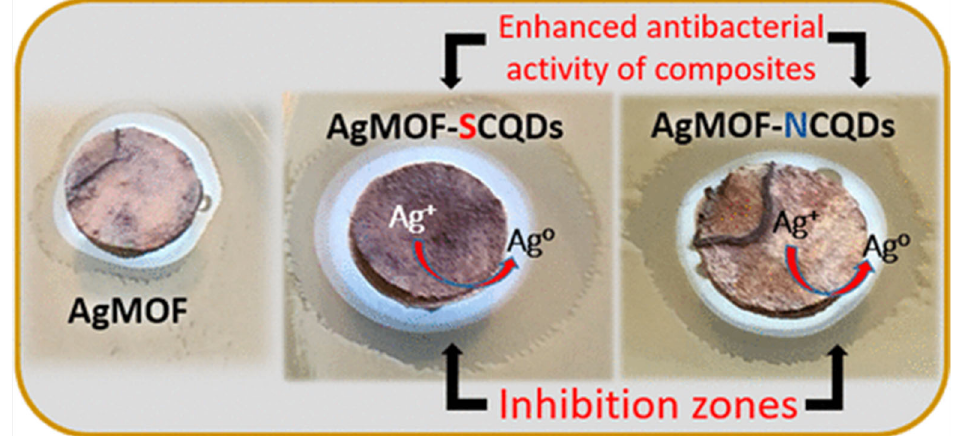
Figure 26. Antimicrobial activity of AgMOFs ‐ S1 and AgMOF ‐ N1 are illustrated with the inhibition zones around the composites. The Ag + released from MOFs have high affinity to the S ‐ compounds of cells, hence forming Ag° and Ag 2 S which are important for the antimicrobial action. Reproduced with permission from [206] .